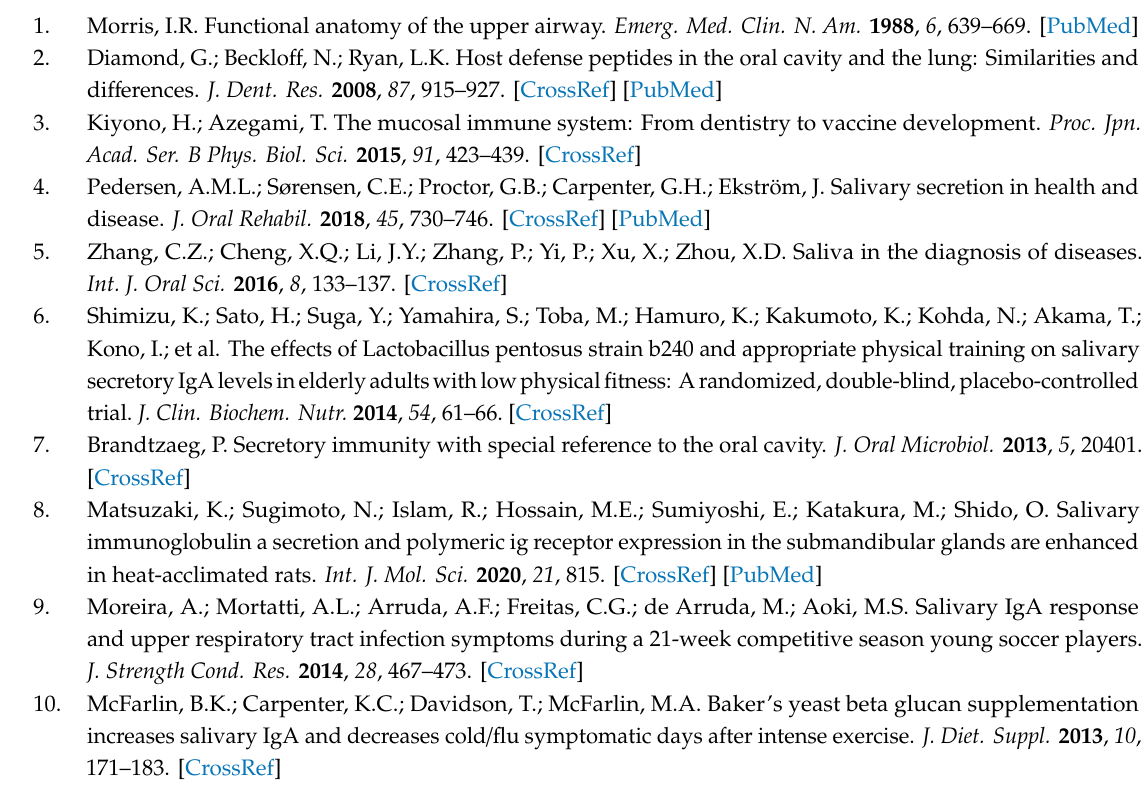
Table S1: Control and polydextrose (PDX) diets (g / kg) composition, Figure S1: E ff ects of polydextrose (PDX) addition on the weight gain (A), weight of the submandibular gland (B), and salivary flow rate